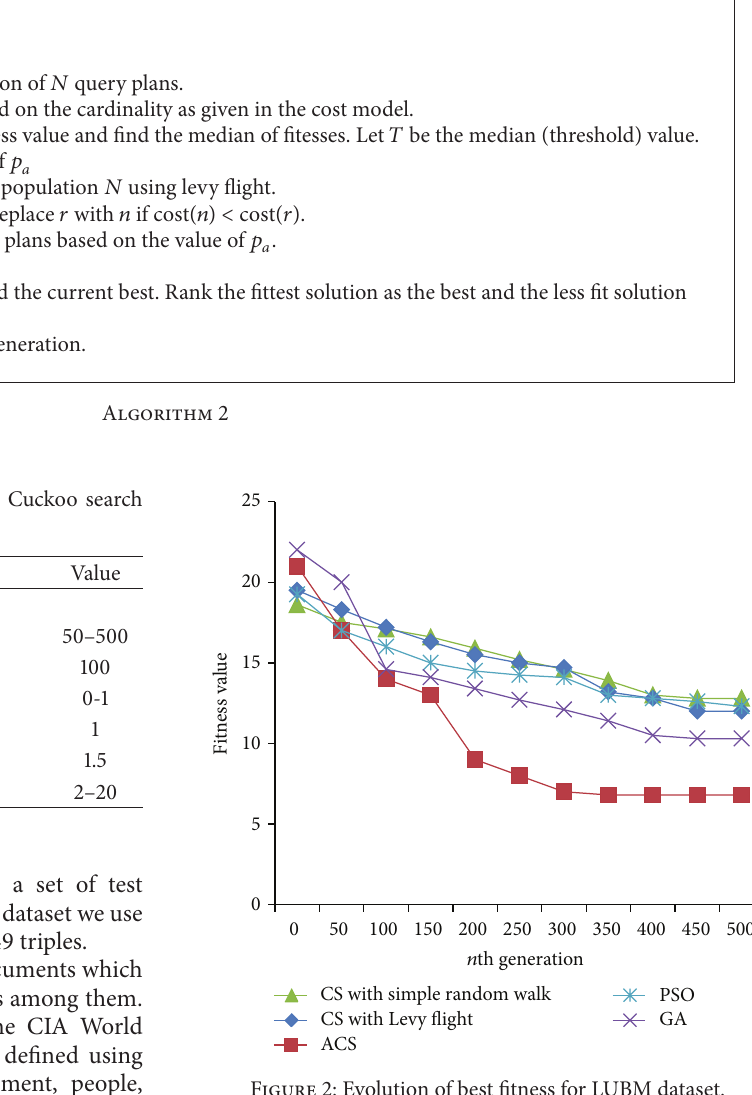
Figure 2: Evolution of best fitness for LUBM